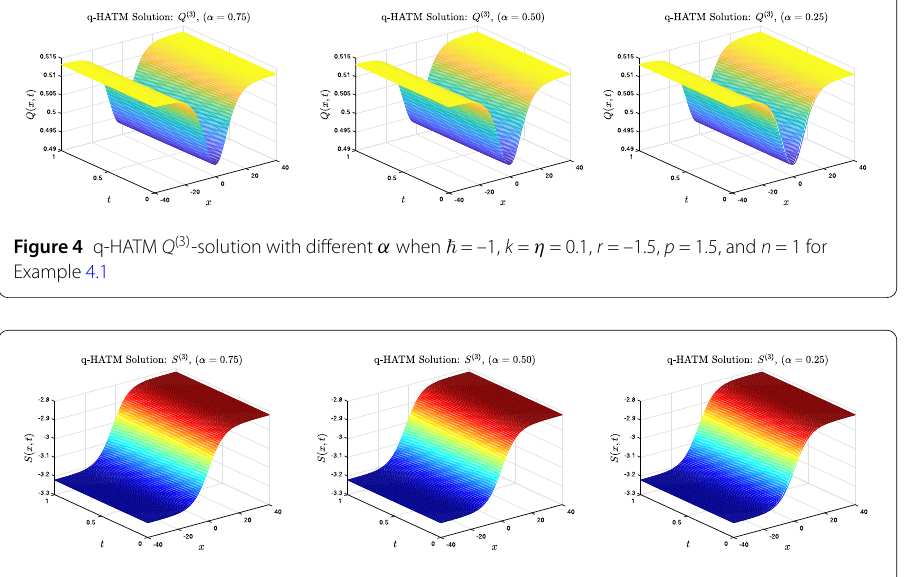
Figure 5 q-HATM S (3) -solution with different α when (cid:2) = –1, k = η = 0.1, r = –1.5, p = 1.5, and n = 1 for Example